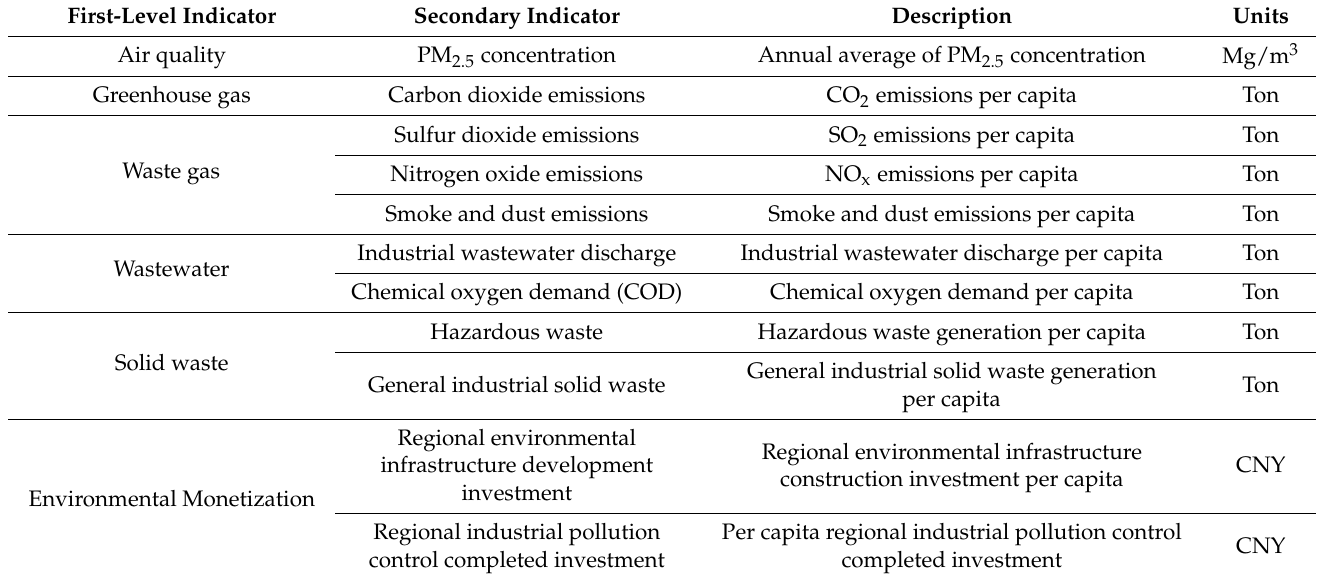
Table 2. Environmental pressure index (EPI) related